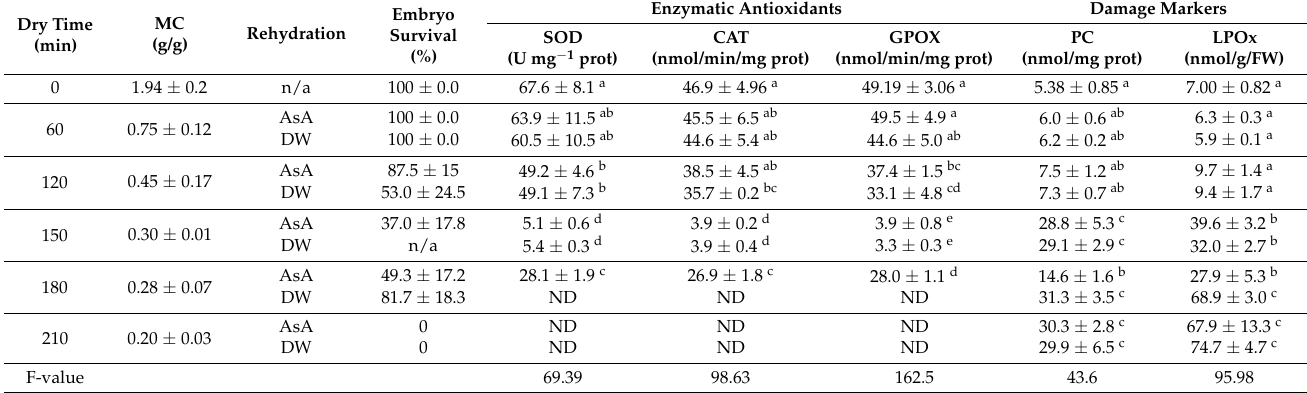
Table 2. The effect of rapid desiccation and rehydration solution on embryo germination, SOD, CAT, GPOX activities and PC and LPOx levels. Data are presented as mean ± SD ( p < 0.05) for six different treatments. Superscript of different letters within a column indicates significant differences at p < 0.05 based on a one-way ANOVA analysis (Tukey HSD